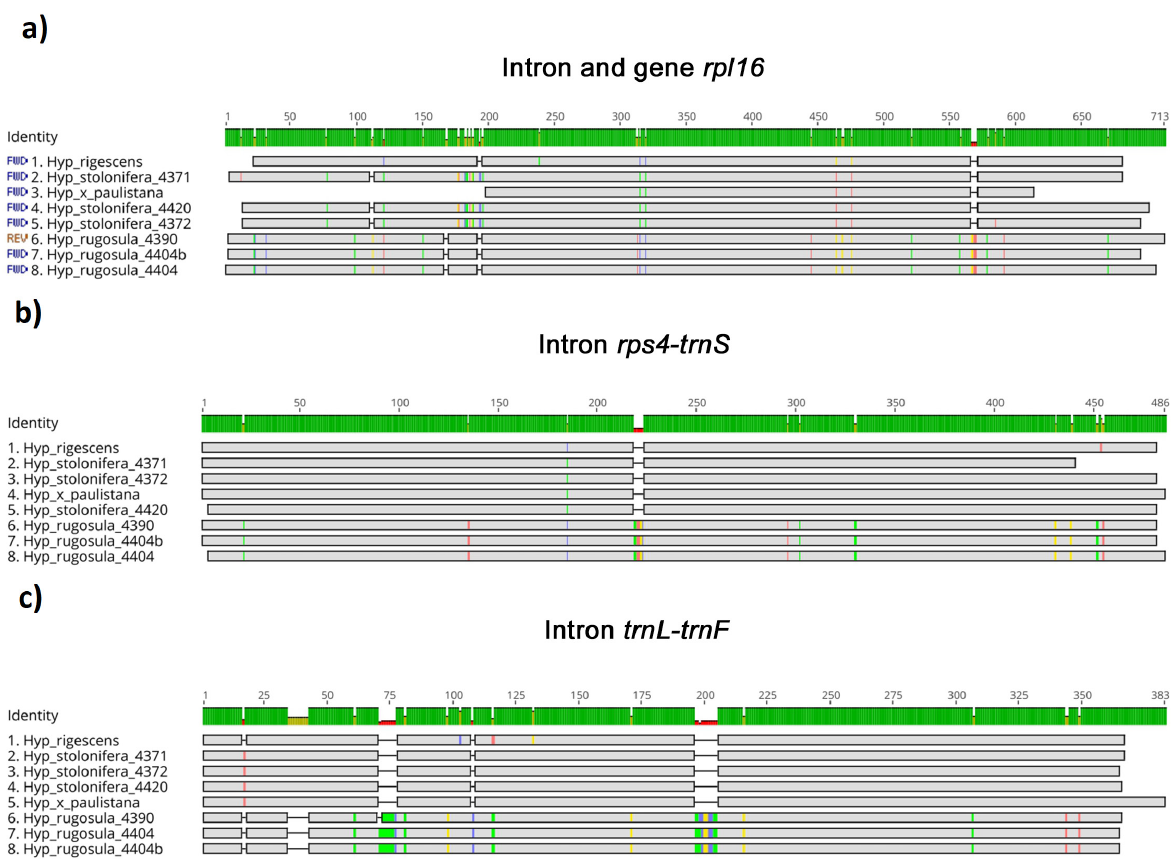
Figure 5. Chloroplast DNA comparison between Hypolepis ×pauslistana, H. rigescens, three specimens of H. rugosula, and three of H. stolonifera. a) intron and gene rpl16 . b) intron rps4-trnS . c) intron trnL-trnF . Gray color refer to nucleobases common to all specimens; pink – adenine; blue – cytosine; yellow – guanine; green –